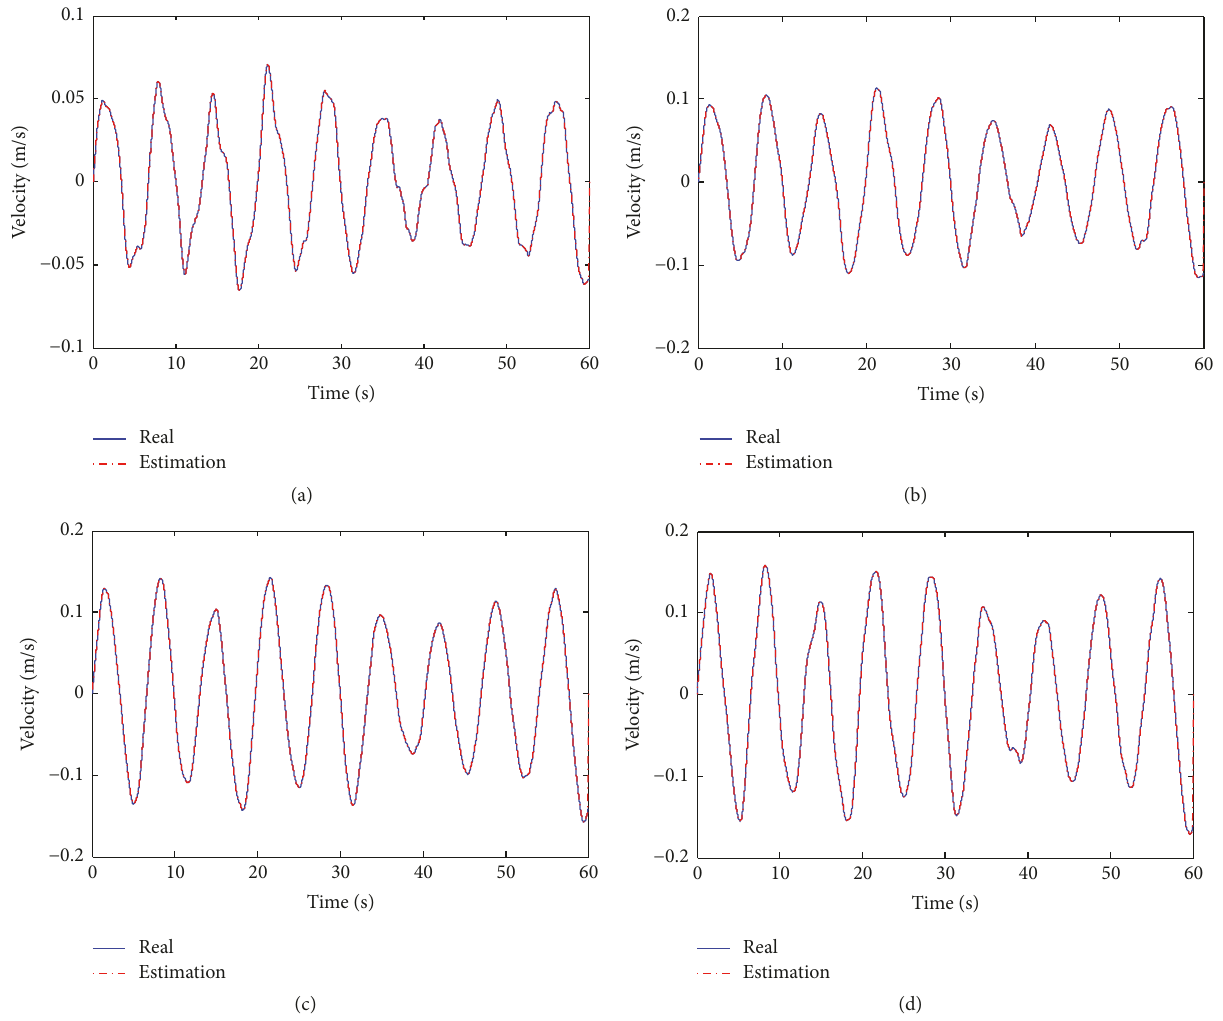
Figure 4: Comparison of time histories of structural velocity responses. (a) On the 5th floor; (b) on the 10th floor; (c) on the 15th floor; (d) on the 20th